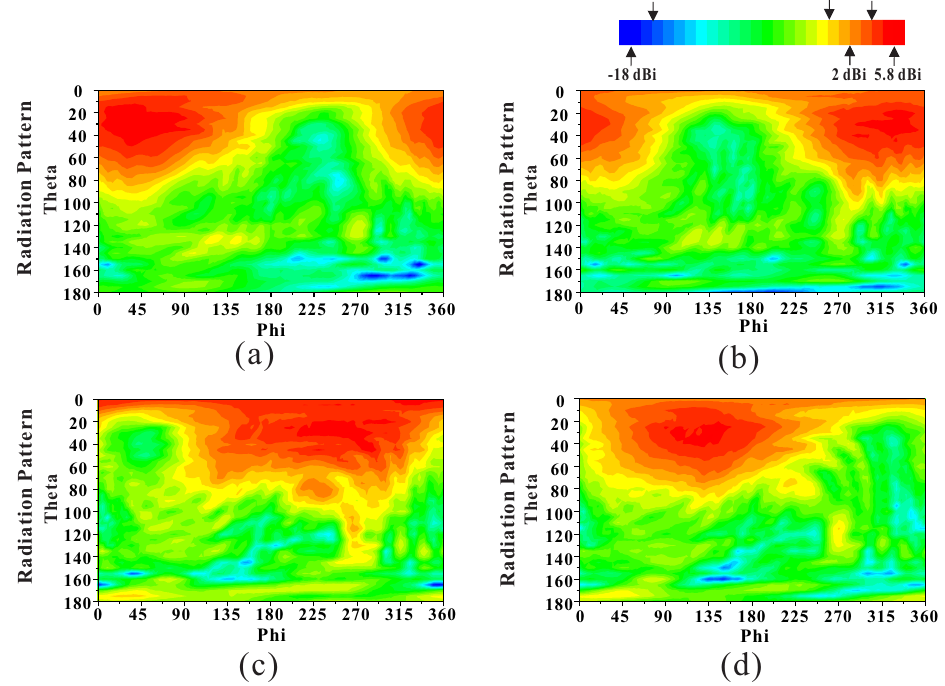
Figure 7. Measured radiation patterns with regard to the azimuth plane at the input modes: ( a ) Mode 1, ( b ) Mode 2, ( c ) Mode 3, and ( d ) Mode